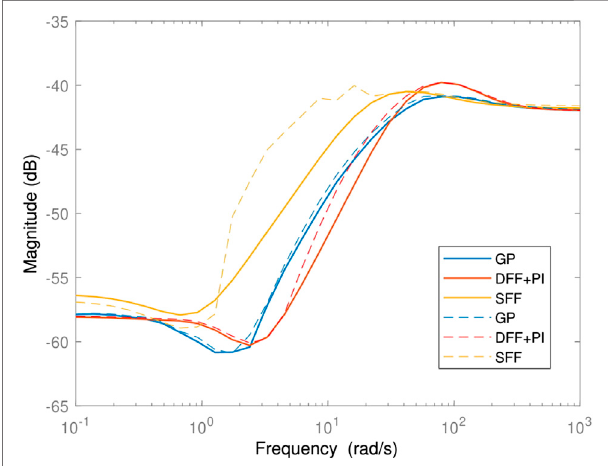
FIGURE 8 | Closed-loop frequency response from the disturbance to the excess ratio. Solid and dashed lines represent the plots obtained using sinusoids of amplitudes 20 and 40 A,